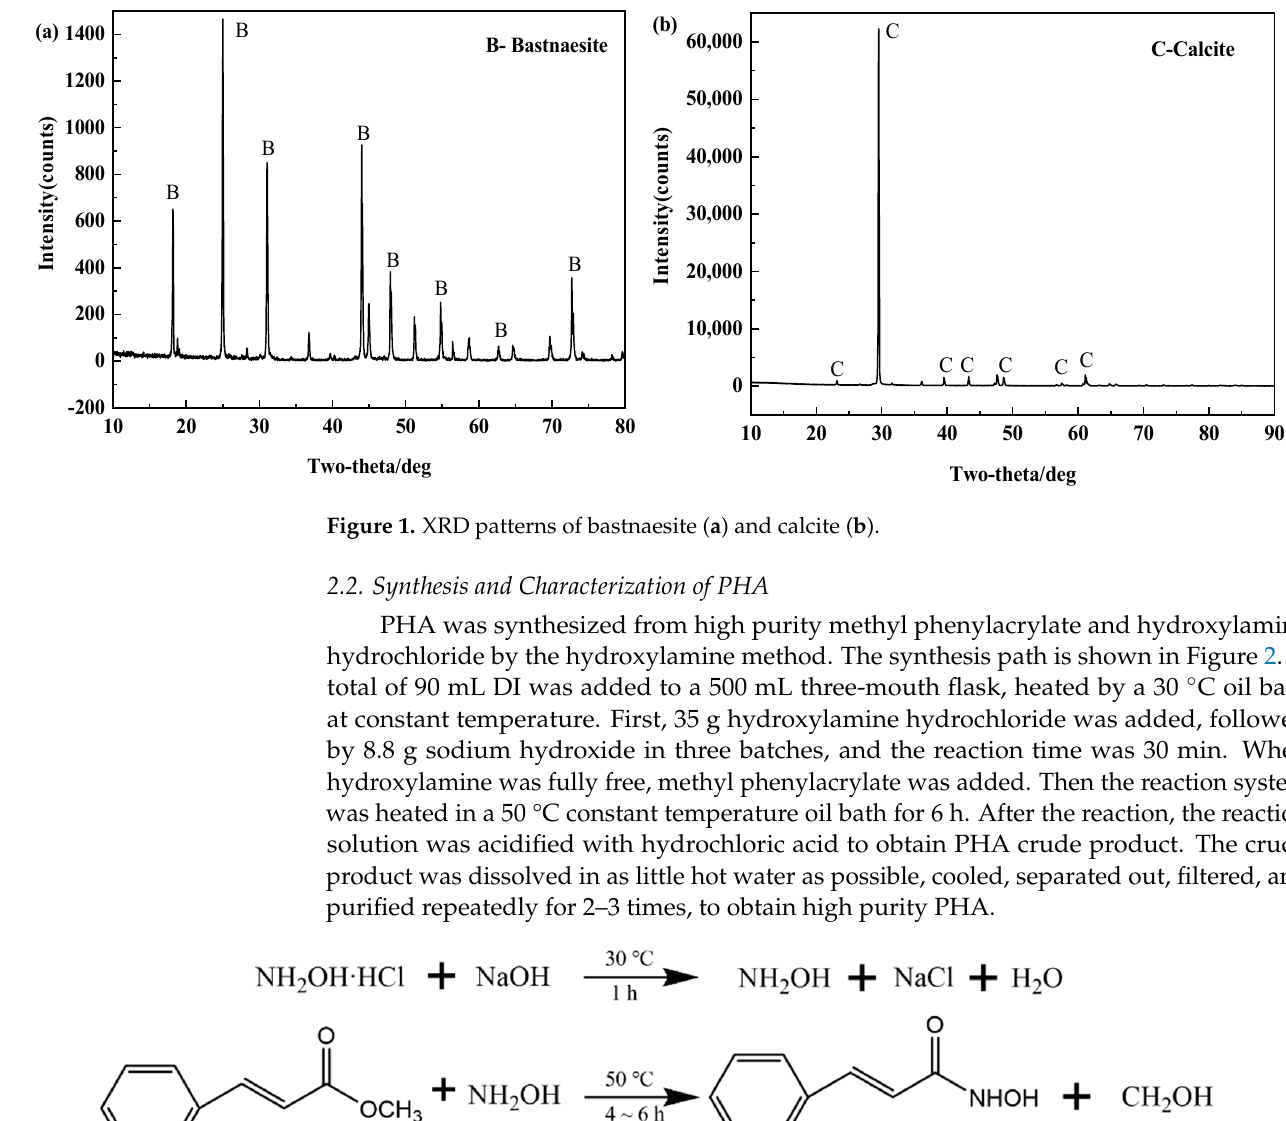
Figure 1. XRD patterns of bastnaesite ( a ) and calcite ( b ). Table 1. Elemental analysis results (%) of bastnaesite and calcite sample.